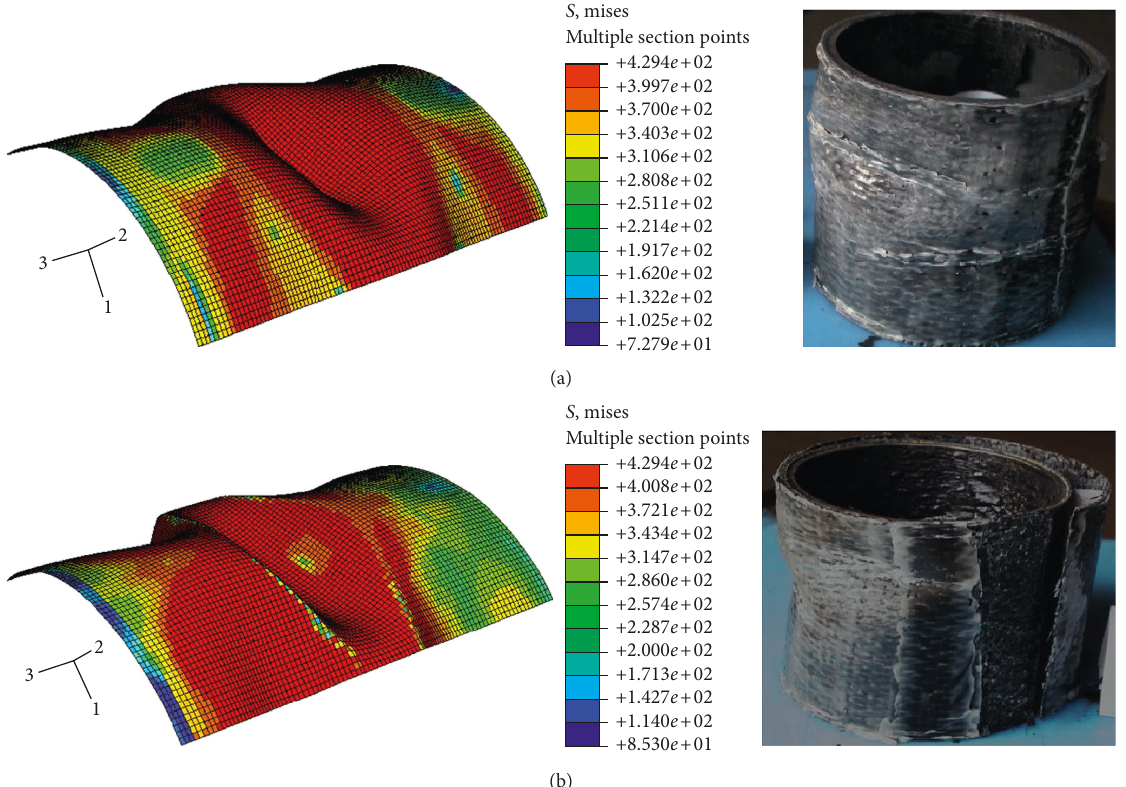
Figure 17: Numerical and experimental inextensional buckling mode: (a) 3 CFRP layers; (b) 4 CFRP layers.